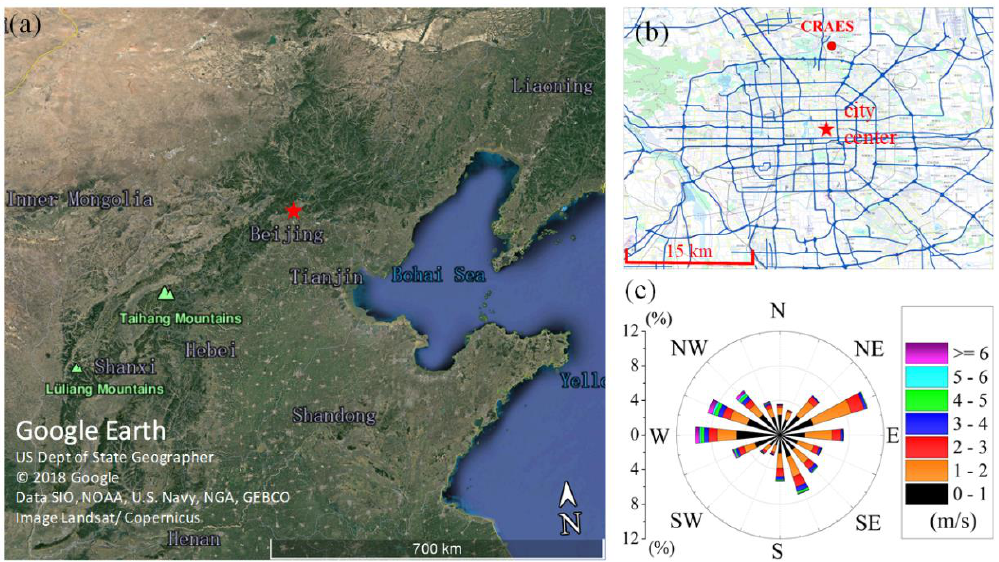
Figure 1. ( a ) A regional view of the position of Beijing on the North China Plain. ( b ) Location of the sampling site, CRAES, in Beijing, and major roads (blue line). The red star denotes the center of Beijing. ( c ) Wind rose plot during the observation period. (The map is from Google Earth.).